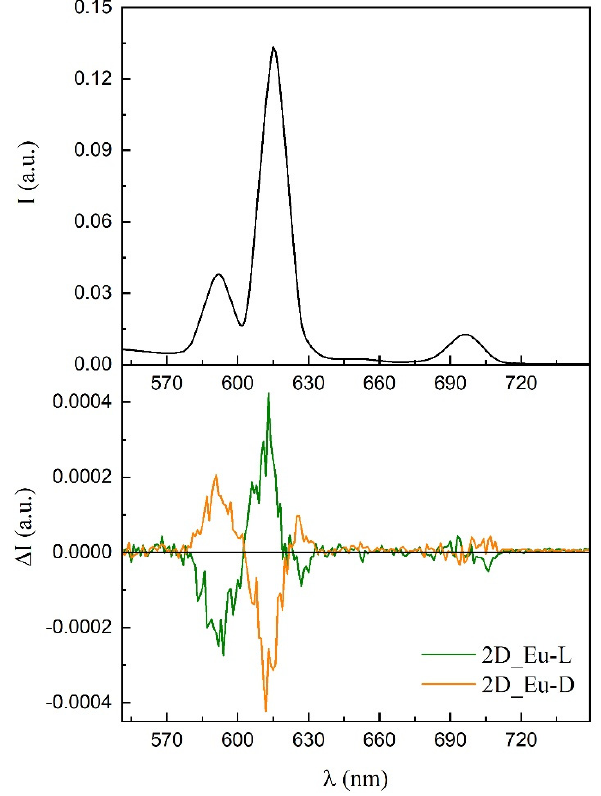
Figure 11. CPL emission plot of the enantiomeric pair of compounds 2D_Eu .